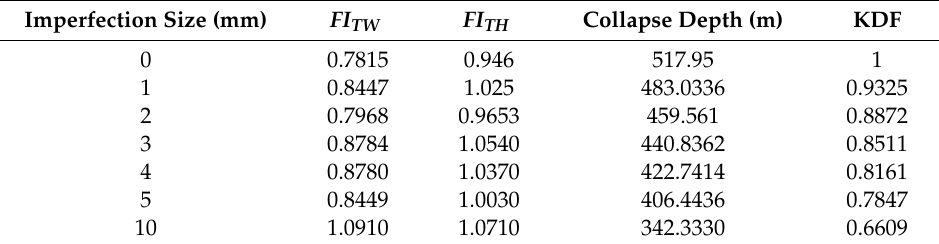
Figure 10. Load-displacement graph for all five imperfections for worst mode imperfection. Table 10. Effect of imperfection on the collapse depth for lowest mode imperfection.